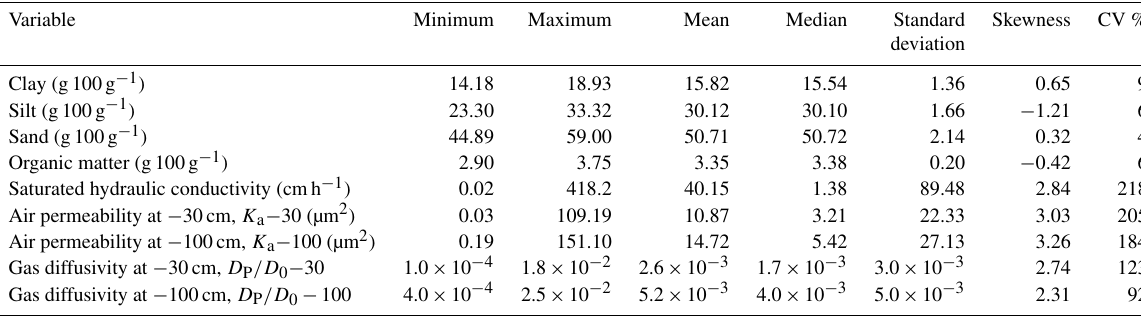
Table 1. Descriptive statistics for selected soil physical properties (no. of samples = 65).